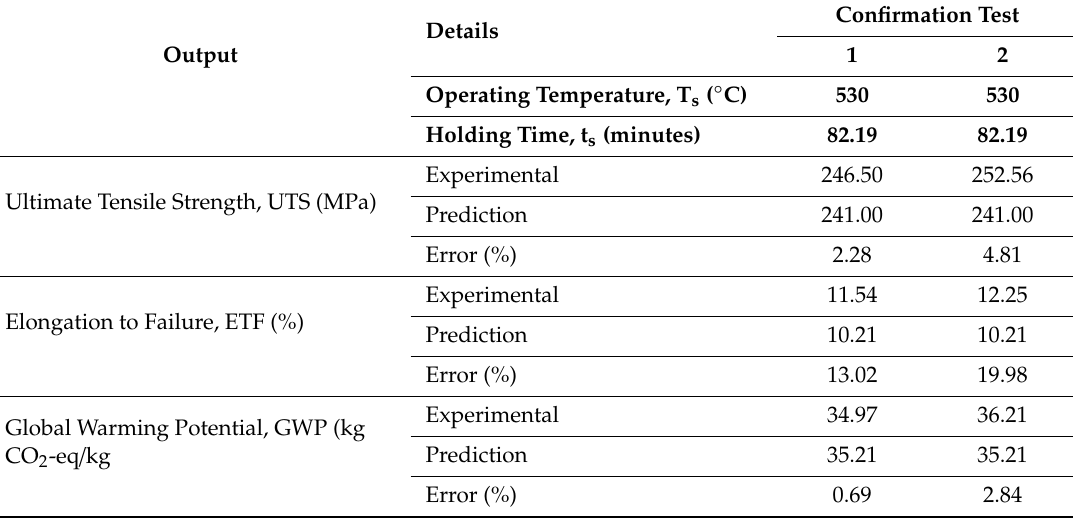
Table 13. Confirmation test and comparison with predicted